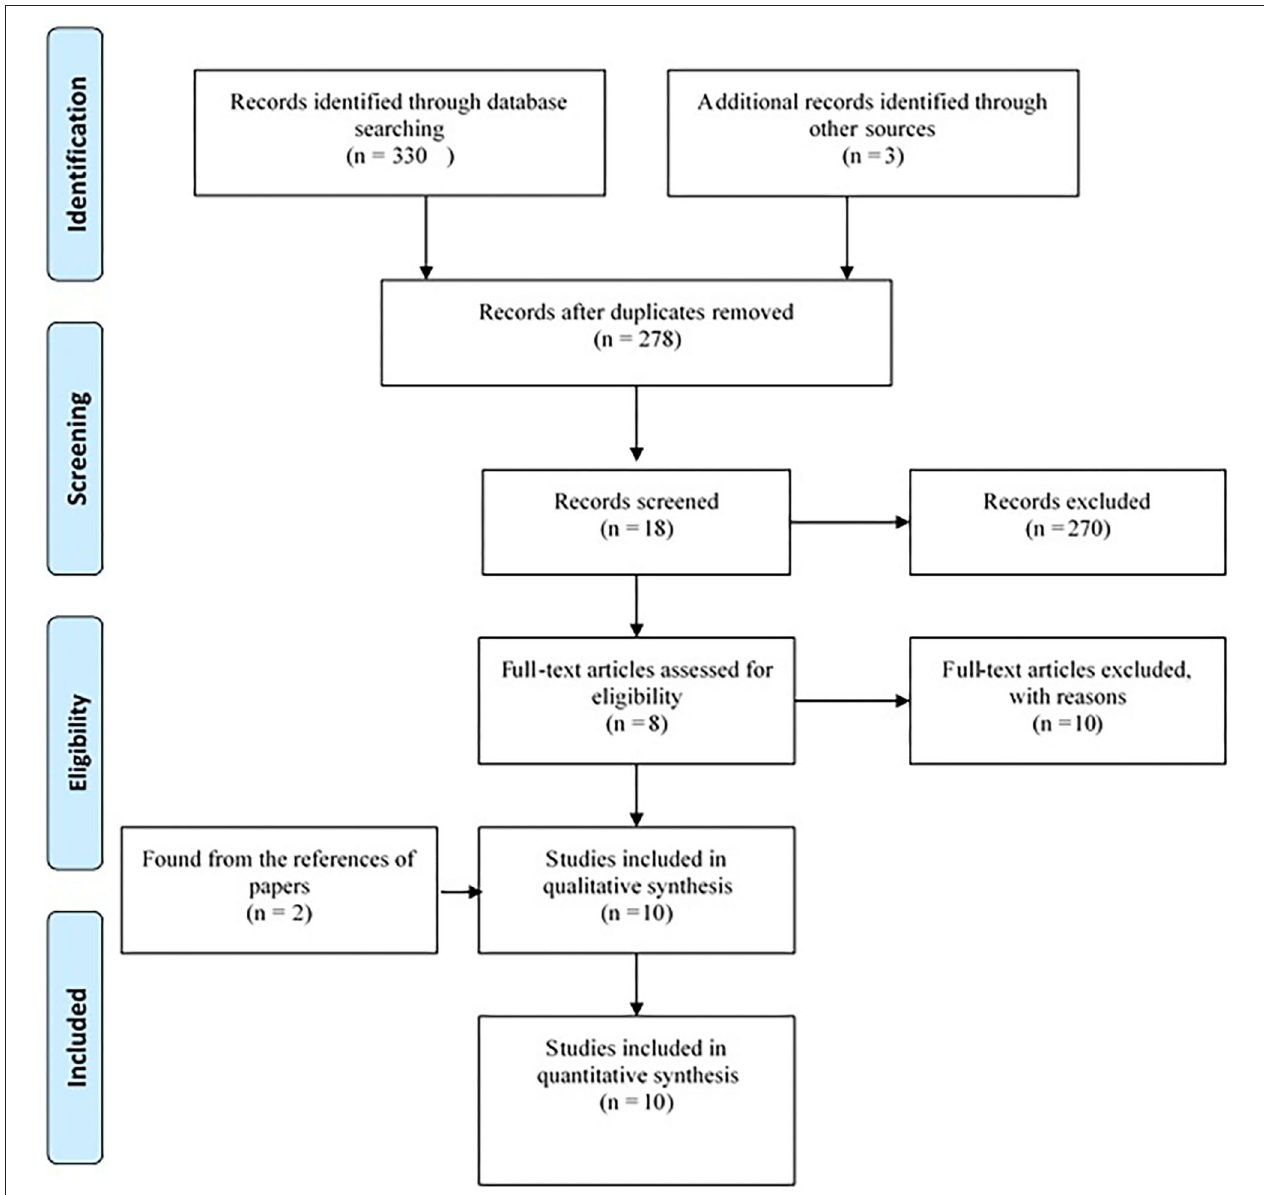
FIGURE 1 | Flow chart of information through the different phases of a systematic review.